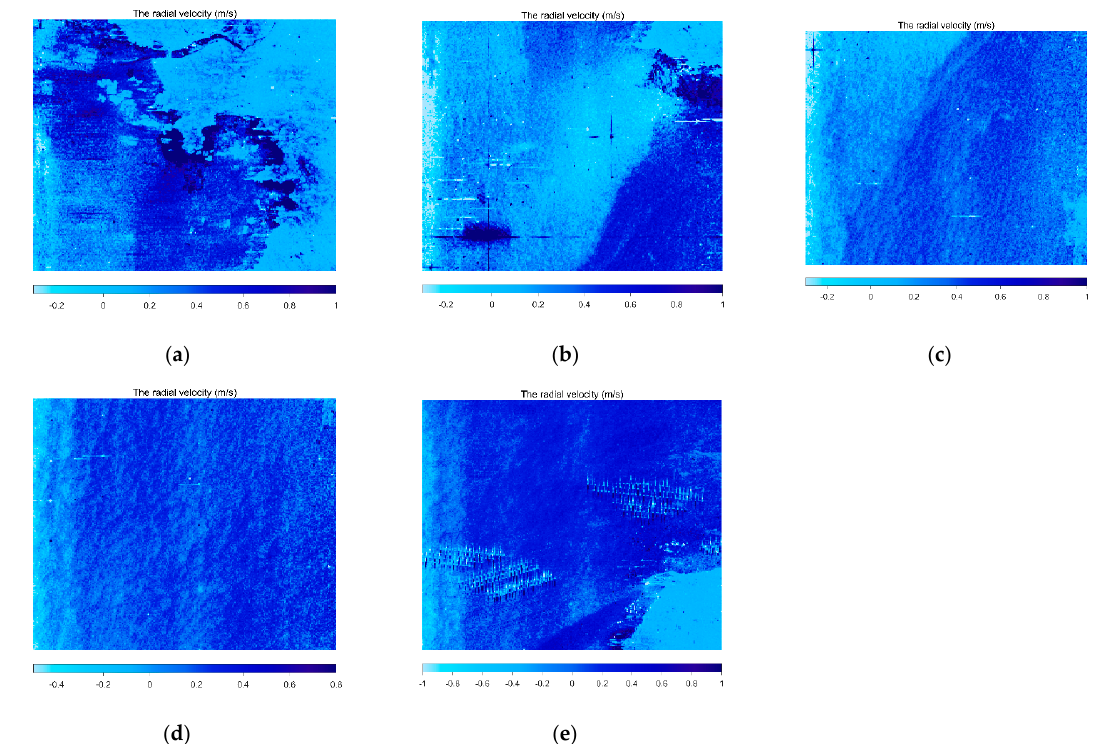
Figure 9. Retrieved radial velocity of SAR images. (a)~(e) are the Retrieved radial velocity from the five scenes in the figure 1.